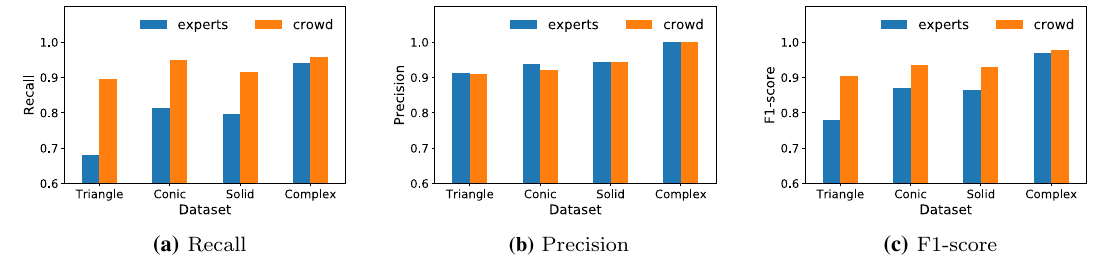
Fig. 6 Evaluation of the crowd-based entity extraction strategy